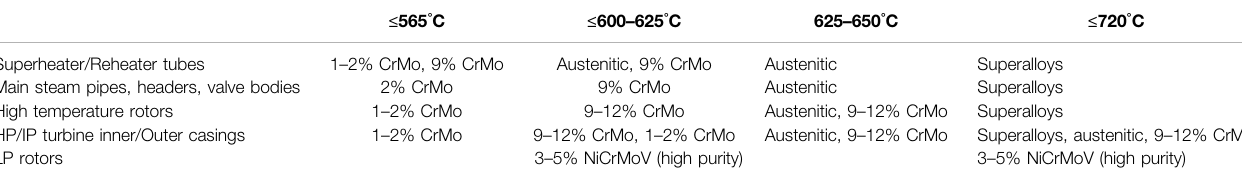
TABLE 6 | Steels used for construction of high temperature steam cycle components (Zörner, 1994).